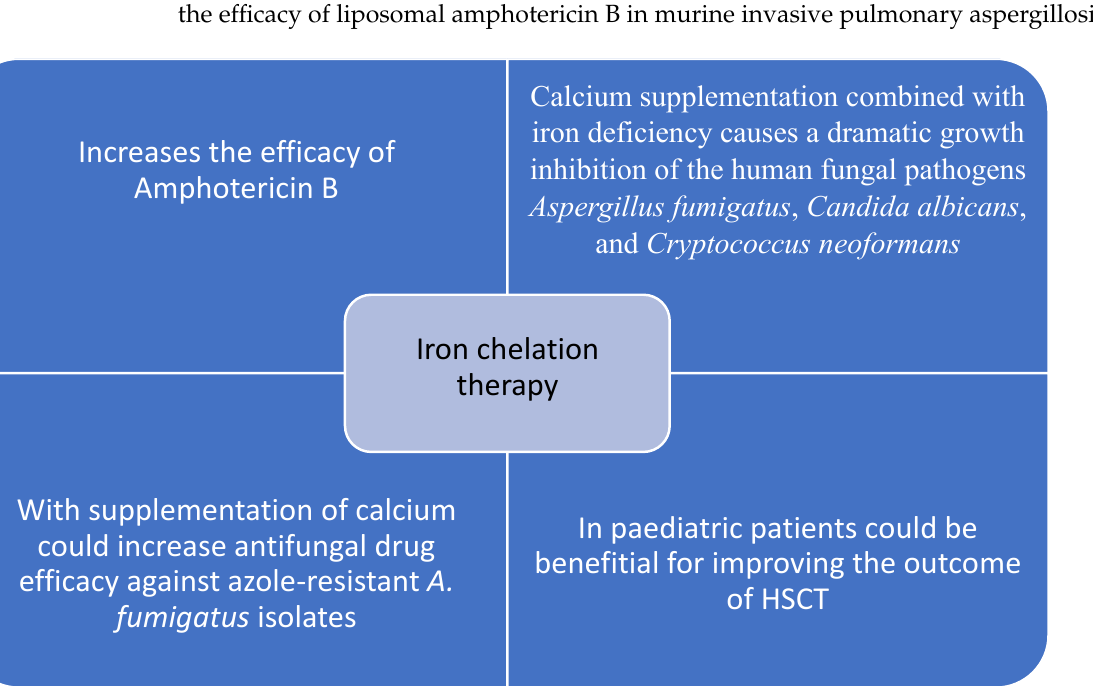
Figure 2. Possible effects of iron chelation on fungal pathogens. The use of iron chelators such as deferasirox increases the efficacy of the antifungal drug amphotericin B in invasive pulmonary aspergillosis [69,70,72] and could reduce infectious complications in pediatric patients undergoing HSCT [74]. Supplementation with calcium along with the use of iron chelators causes dramatic growth inhibition of the human fungal pathogens and increases efficacy of antifungal drugs [73].